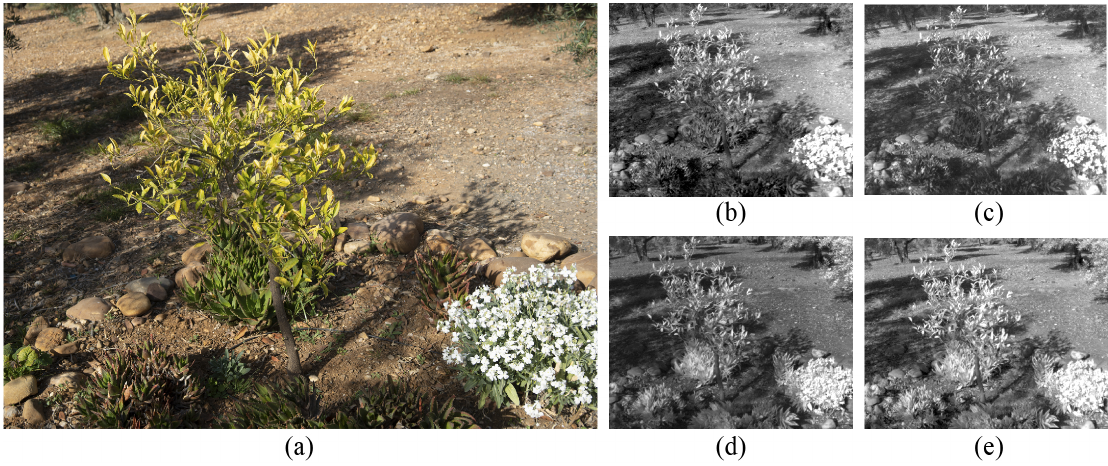
Figure 2. The captured images: ( a ) RGB image, ( b ) green, ( c ) red, ( d ) NIR and ( e ) REG.